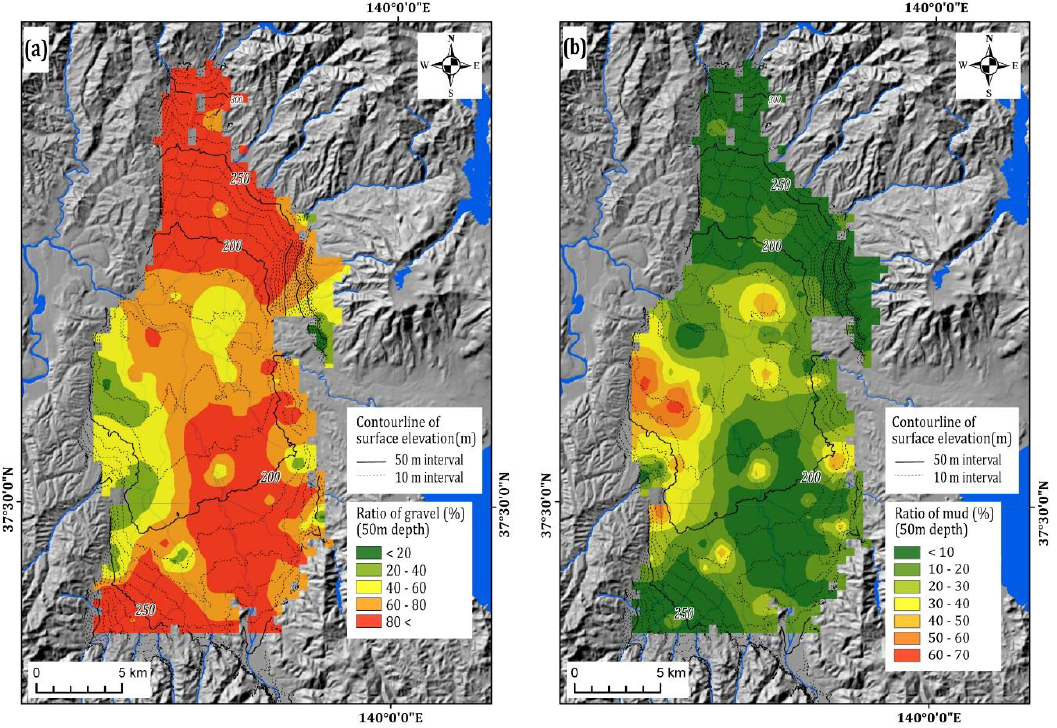
Figure 5. Ratio of ( a ) gravel and ( b ) mud layer up to 50 m depth. Relief map and elevation contour lines are drawn from the 50 m grid digital elevation map of the Geospatial Information Authority of Japan (GSI).